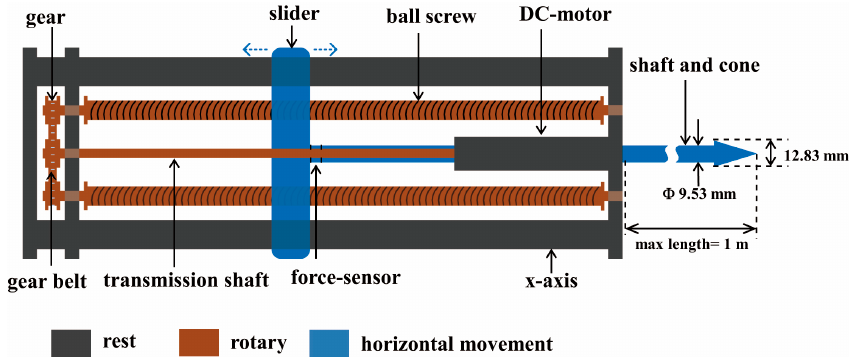
Figure 2. The mechanical structure and working principle of the penetrometer designed, where the black color refers to the rest part (frame), the brown color to the rotary part (crew-drive shafts), and blue color to the horizontal movement part (slide, penetration shaft and cone).